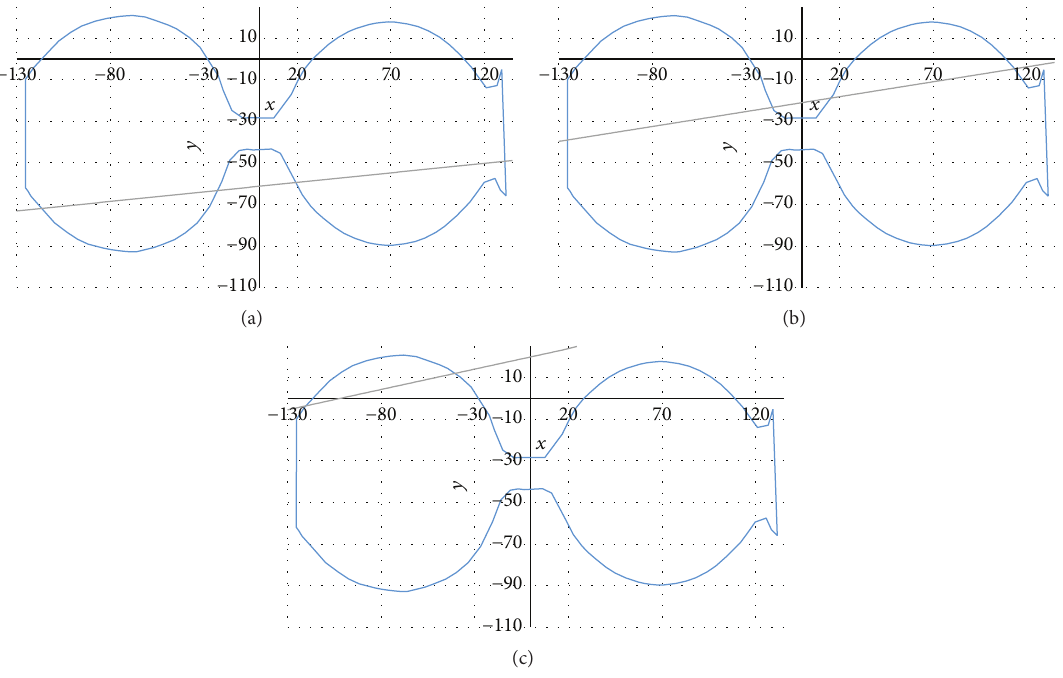
Figure 8: Examples for the B-spline interpolation of the surface points of two plastic bottles and different intersecting lines. The computed intersection lengths are (a) 209.91 , (b) 213.25 , and (c) 82.11